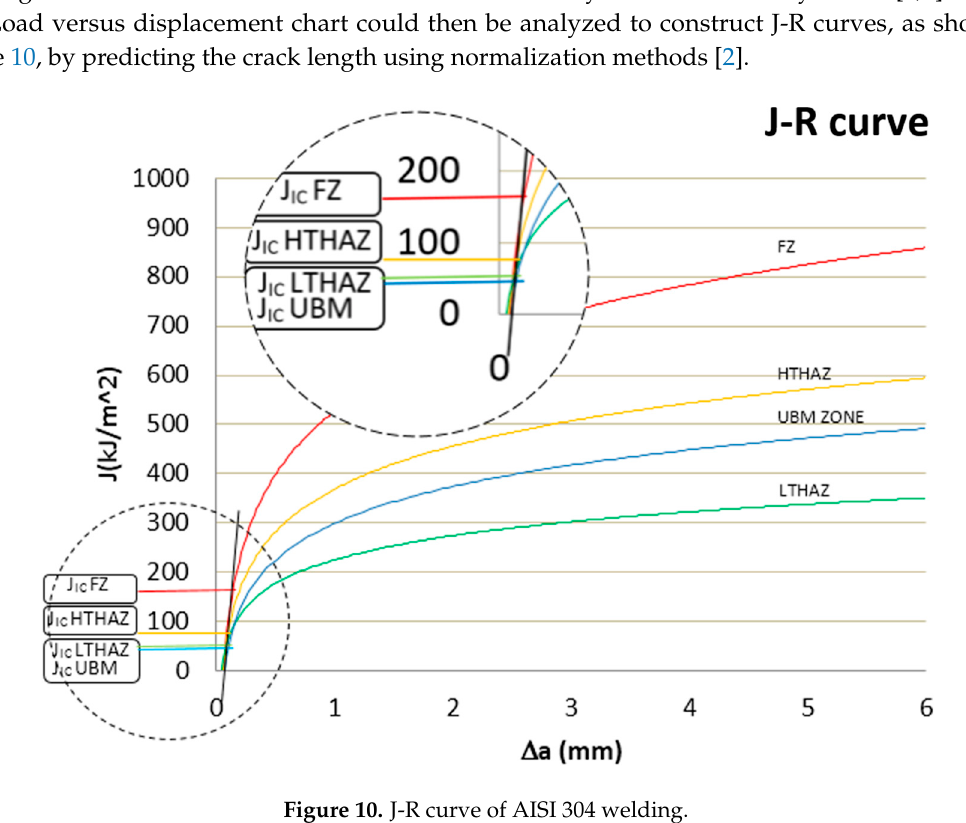
Figure 10. J-R curve of AISI 304 welding.